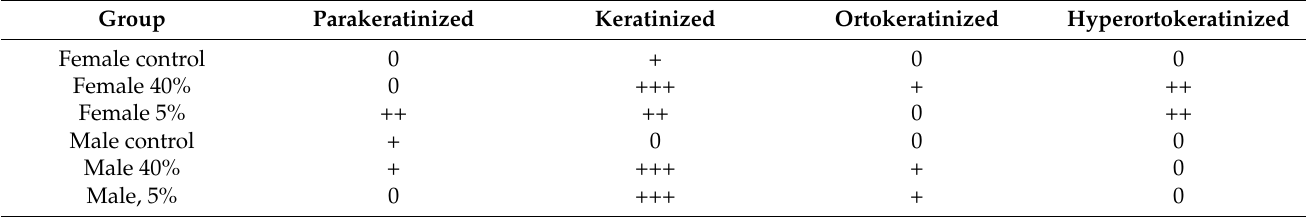
Table 3. Type of surface layer on the tongue after 3 months of weekend alcohol at 5% and 40% in both females and